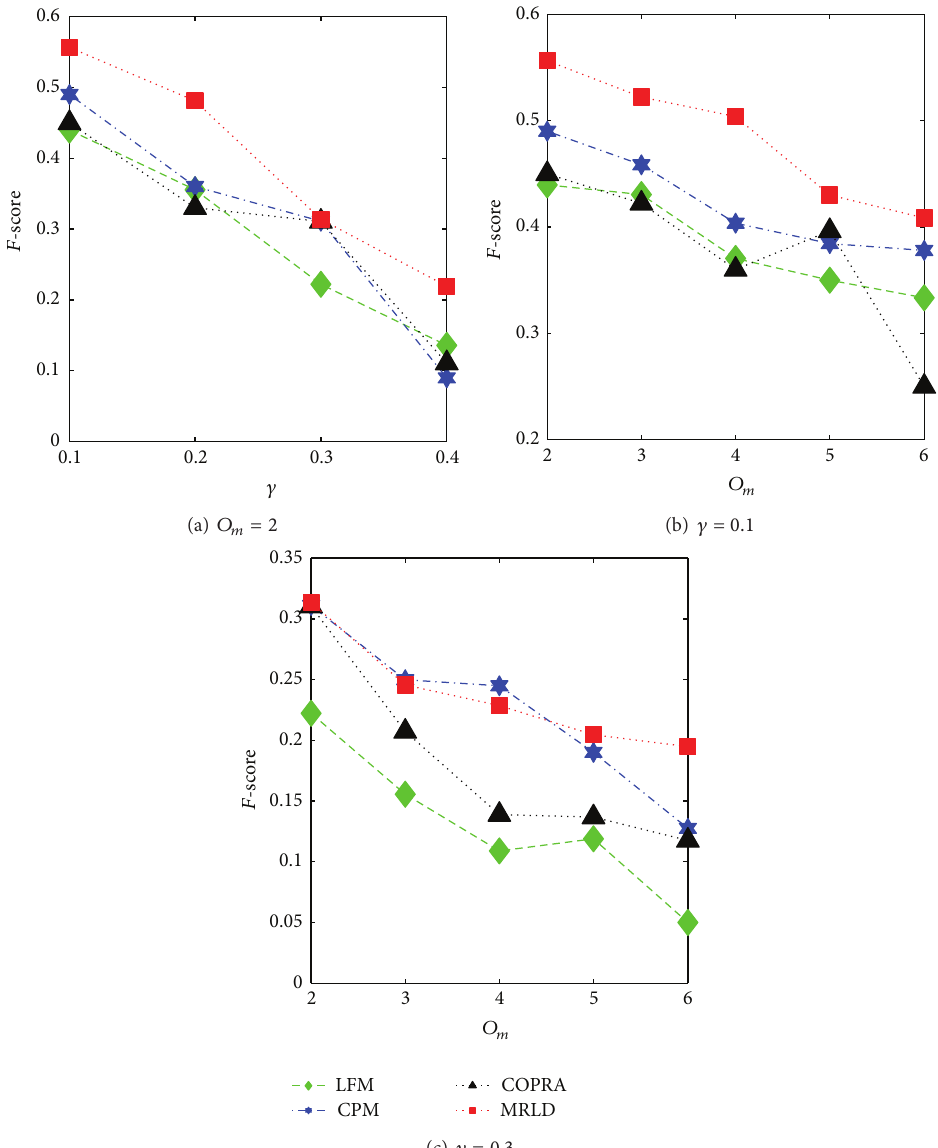
Figure 5: Comparison of MRLD with other algorithms in terms of 𝐹 -score in low-density networks ( 𝑂 𝑛 = 20